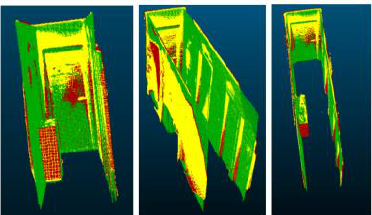
Figure 20. Superposition of the point clouds of the corridor scene from MLS (in green), from the Kinect Azure without depth image processing (red) and Kinect Azure with depth image processing (in yellow).